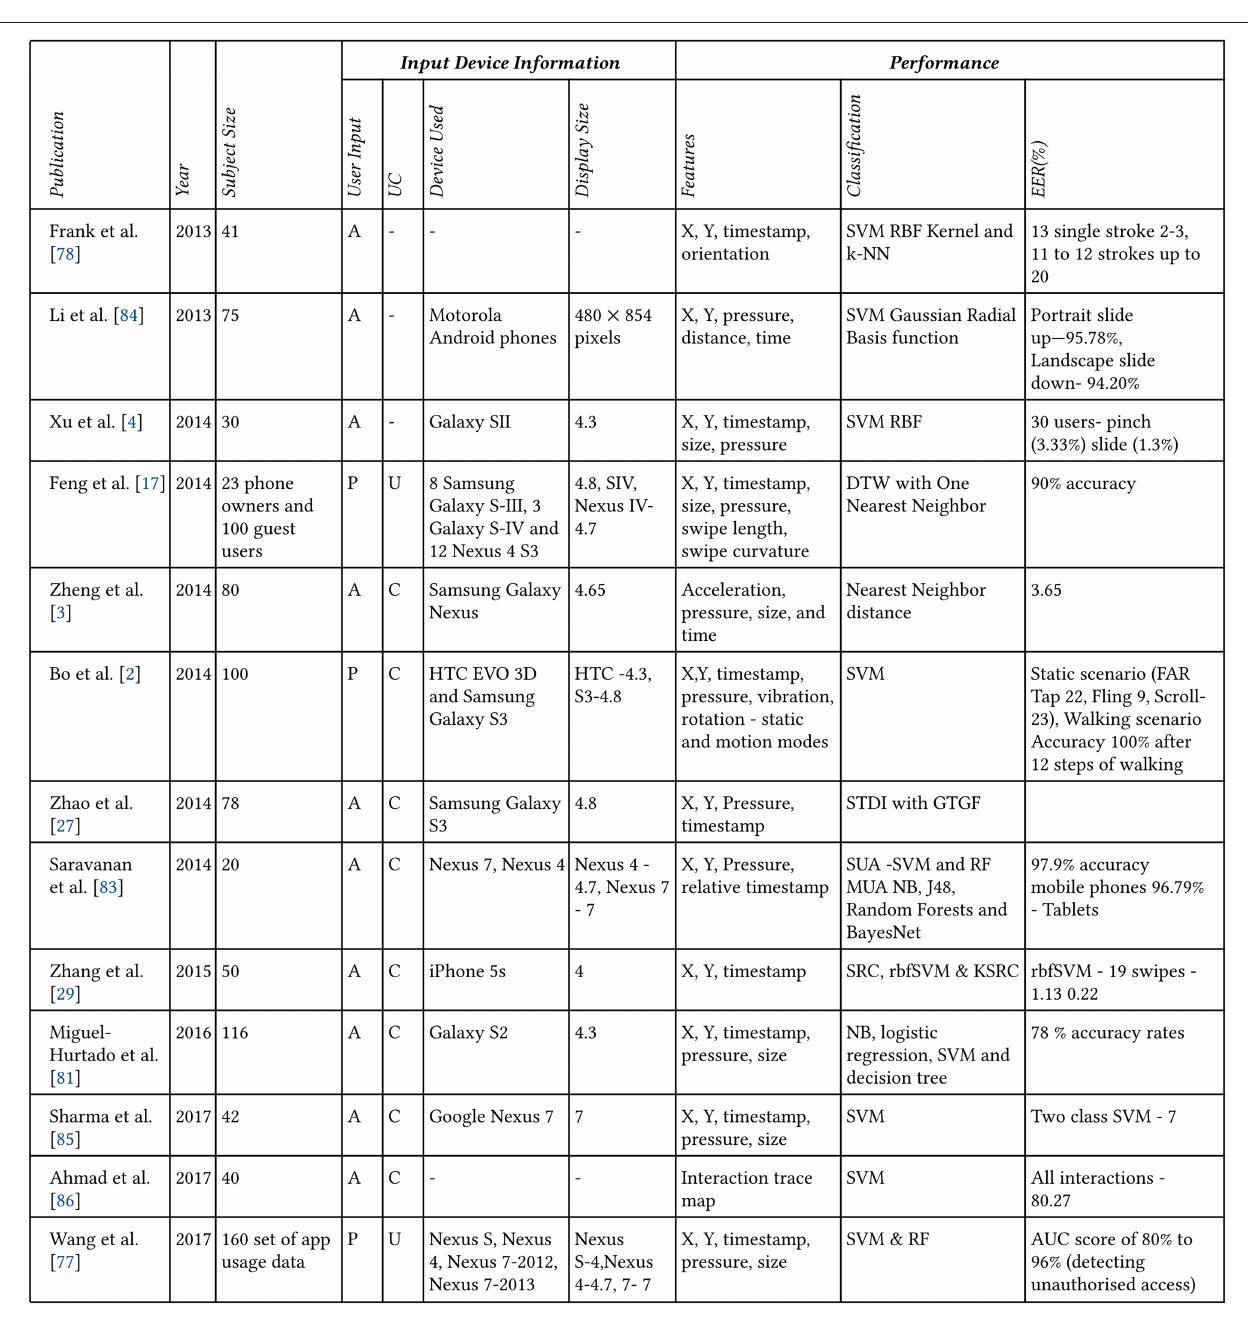
with a smartphone. In fact, research has proven the swipe to be a reliable means of identifying users ( Ellavarason et al., 2020). In real time, the swiping can adapt to the touchscreen while the touchscreen’s intelligent interface adapts to the human swiping, implementing co-adaptation (Beckerle et al.,